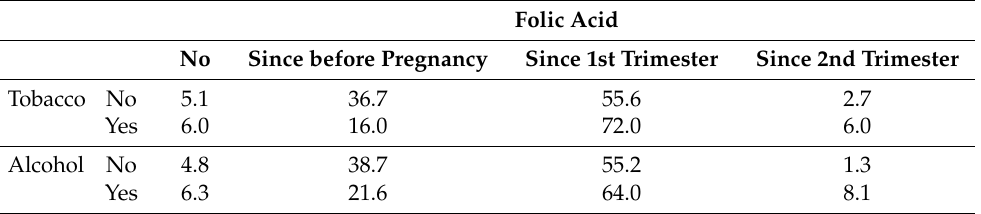
Table 6. Frequency of folic acid intake by tobacco and alcohol